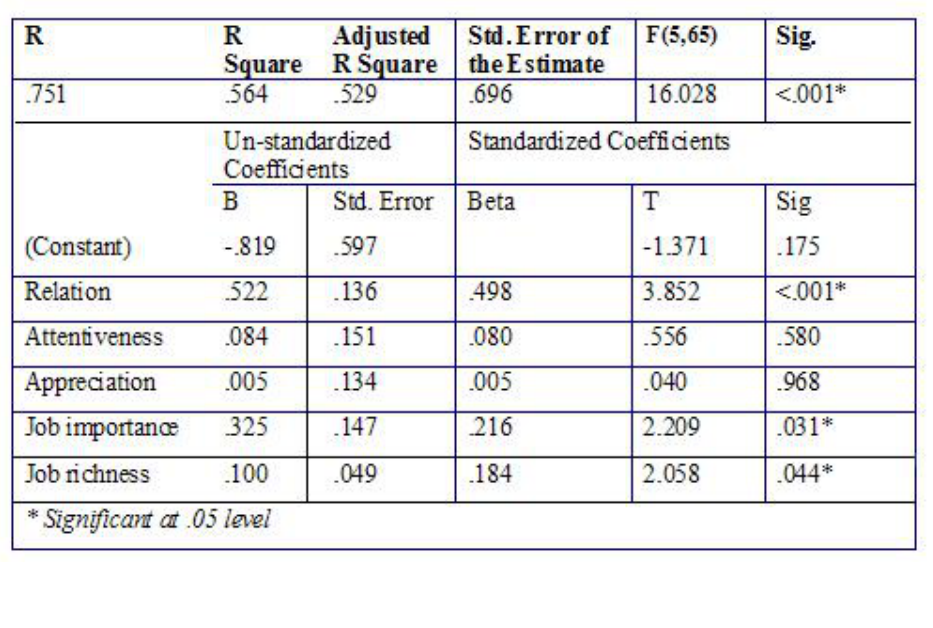
Table 2. A Univariate Regression Analysis for variables predicting "Identification with the university."